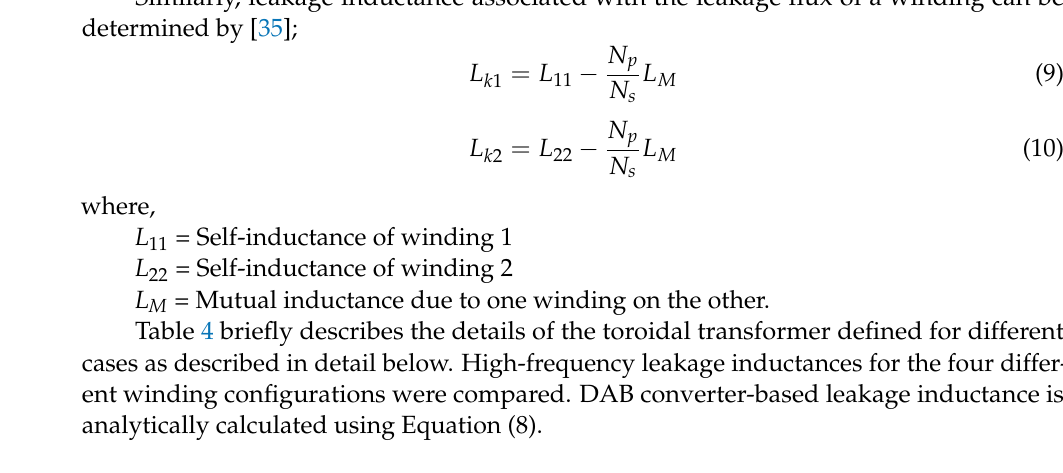
Table 4. Design parameters for different cases of toroidal transformer.